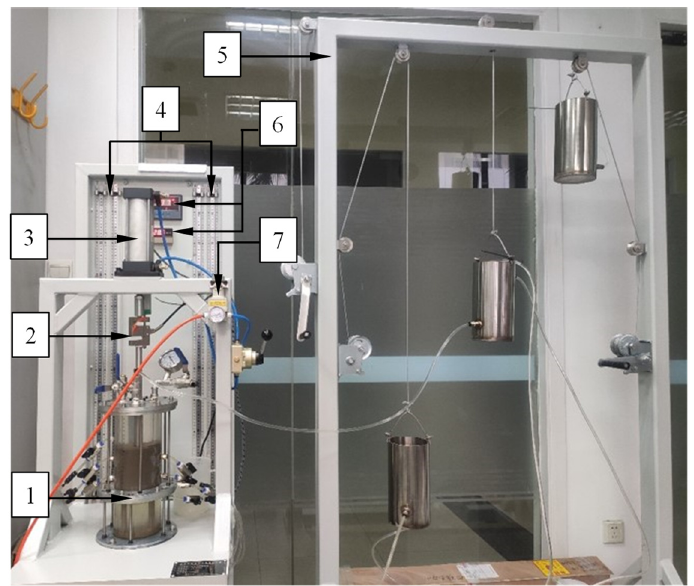
Figure 4. Picture of the test apparatus (legend: 1—permeameter chamber, 2—dynamometer-LVDT, 3—a cylinder, 4—piezometers, 5—water supply overflow system, 6—stress and strain digital display instrument, and 7—pressure-regulating valve).